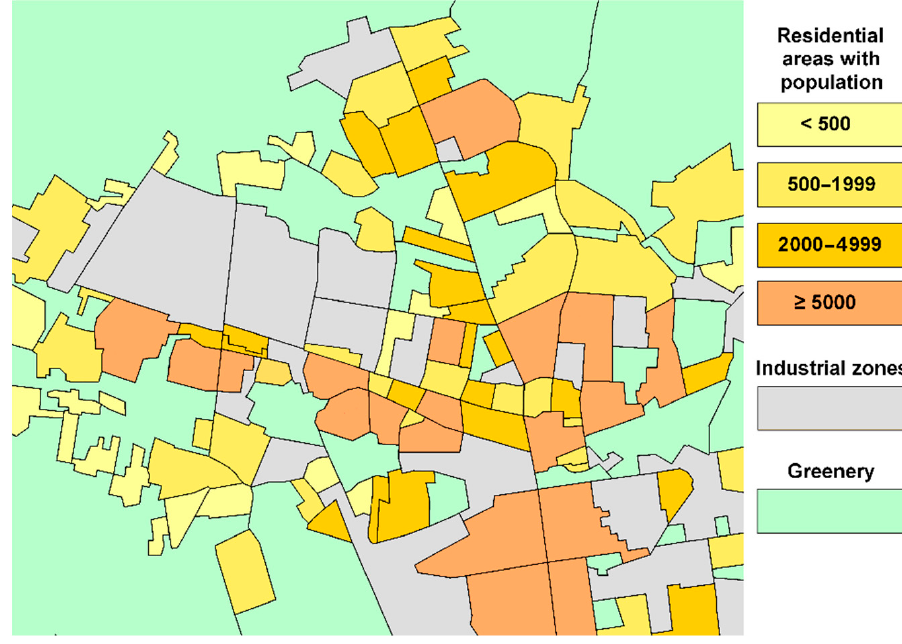
Figure 2. The division of exposed area into zones and population of residential areas.